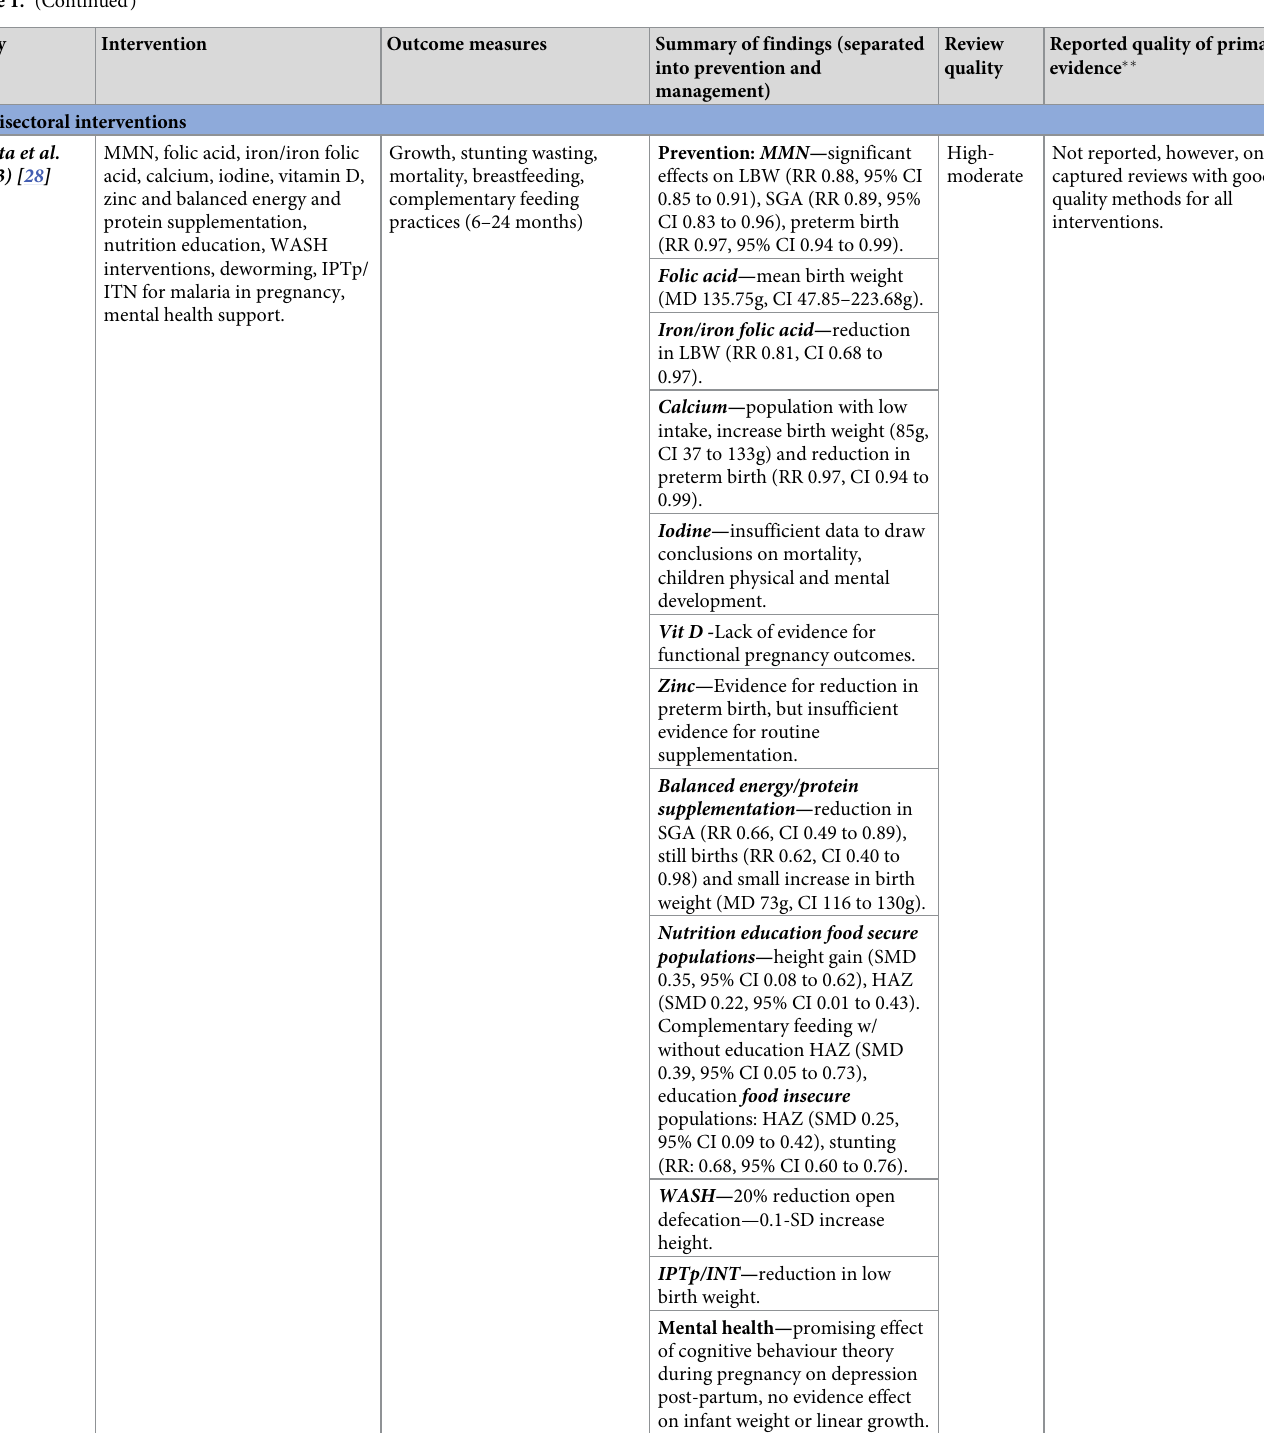
Vit D - Lack of evidence for functional pregnancy